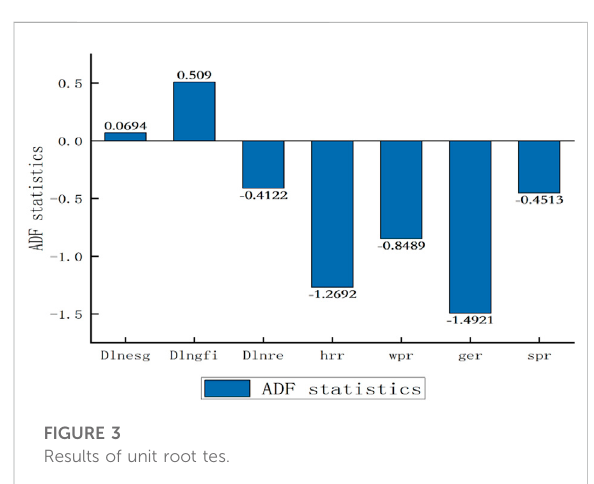
FIGURE 3 Results of unit root